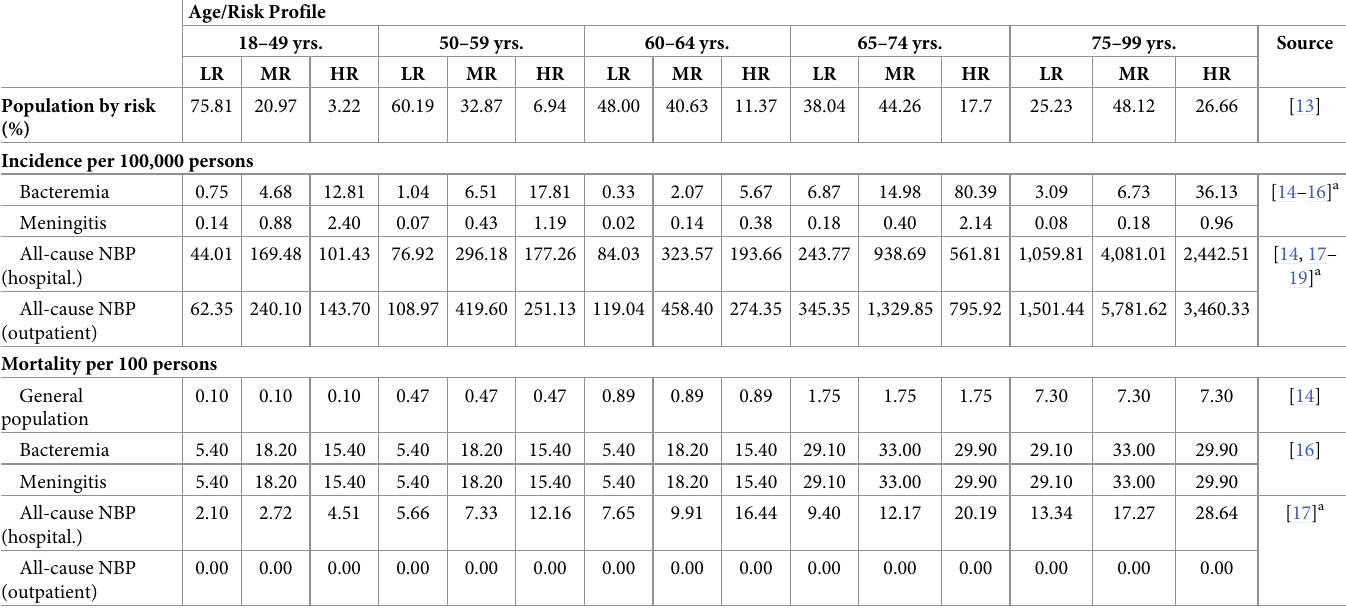
Table 1. Age and risk level specific demographic and epidemiological